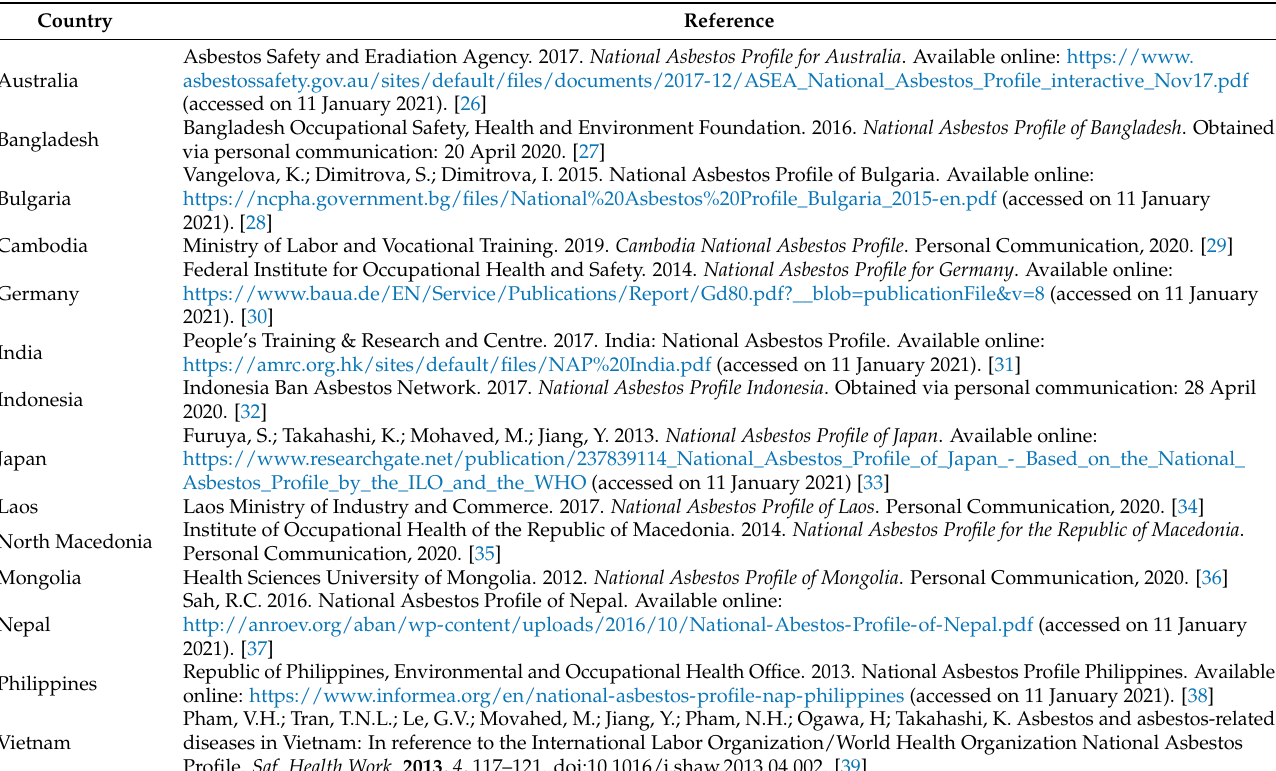
Table A1. List of bona fide National Asbestos Profiles and their